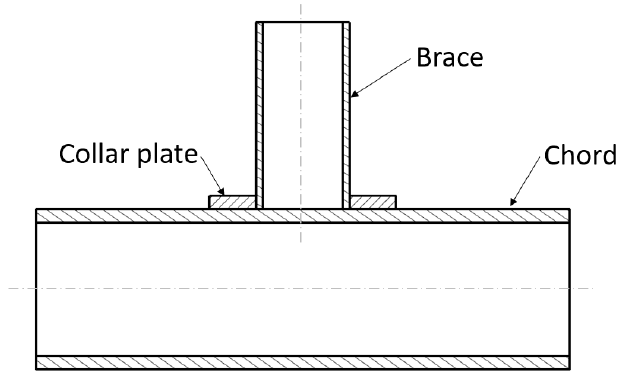
Figure 11. Collar plate reinforced T-joint.